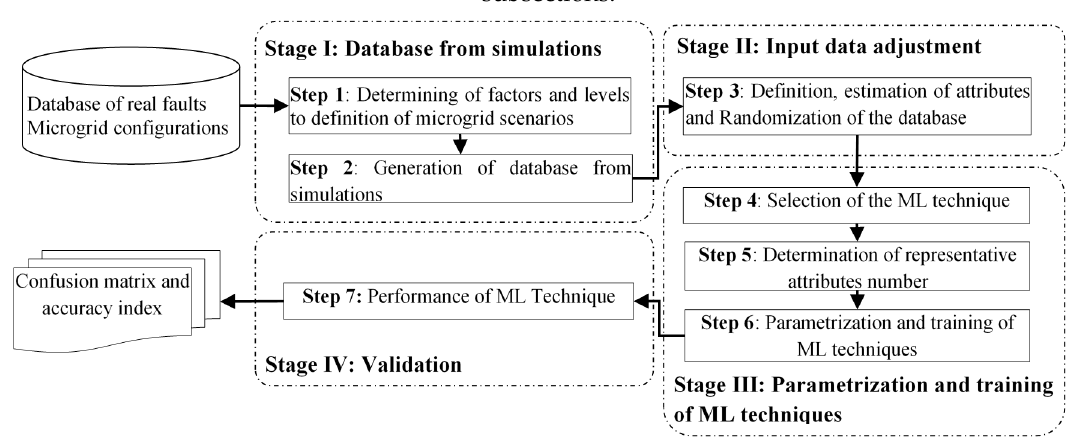
Figure 2. Flowchart for the proposed fault detection system for microgrids.